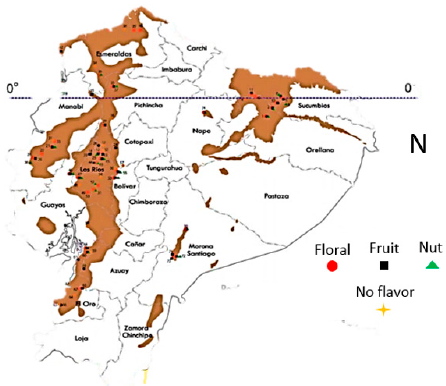
Figure 2. Map of geographical area of Arriva cocoa cultivars in Ecuador.